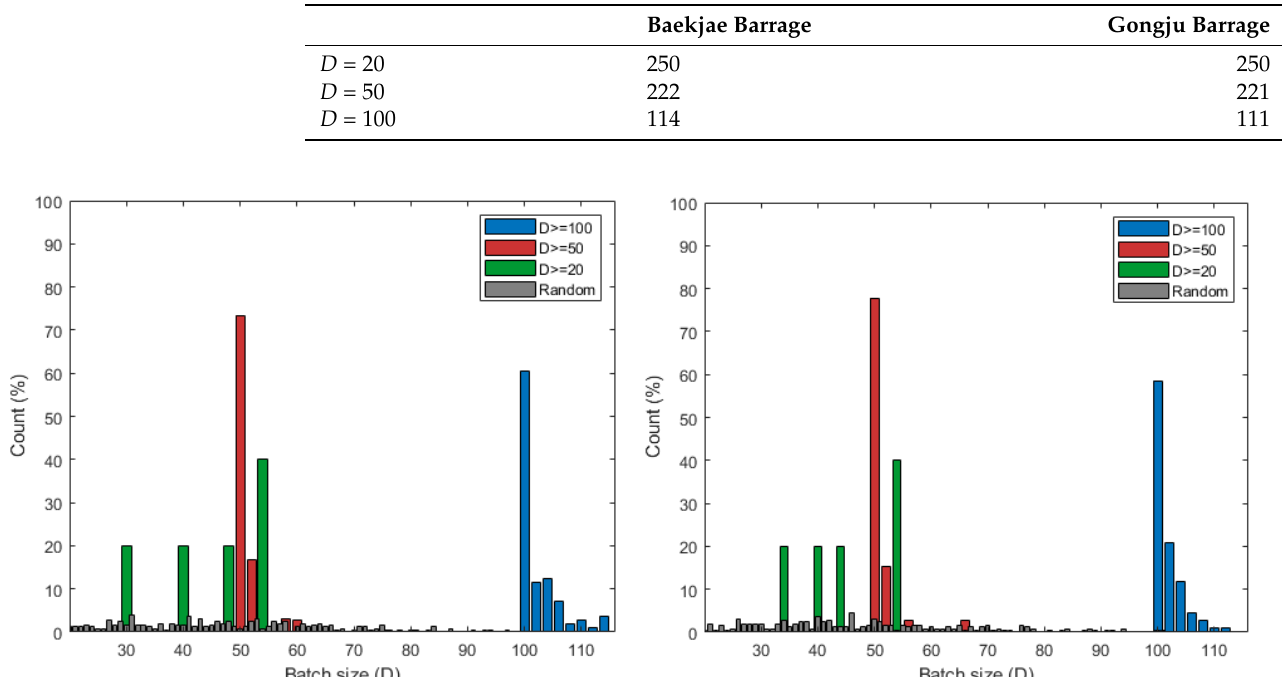
Table 3. Cumulative total values of edges that satisfy the training threshold D .